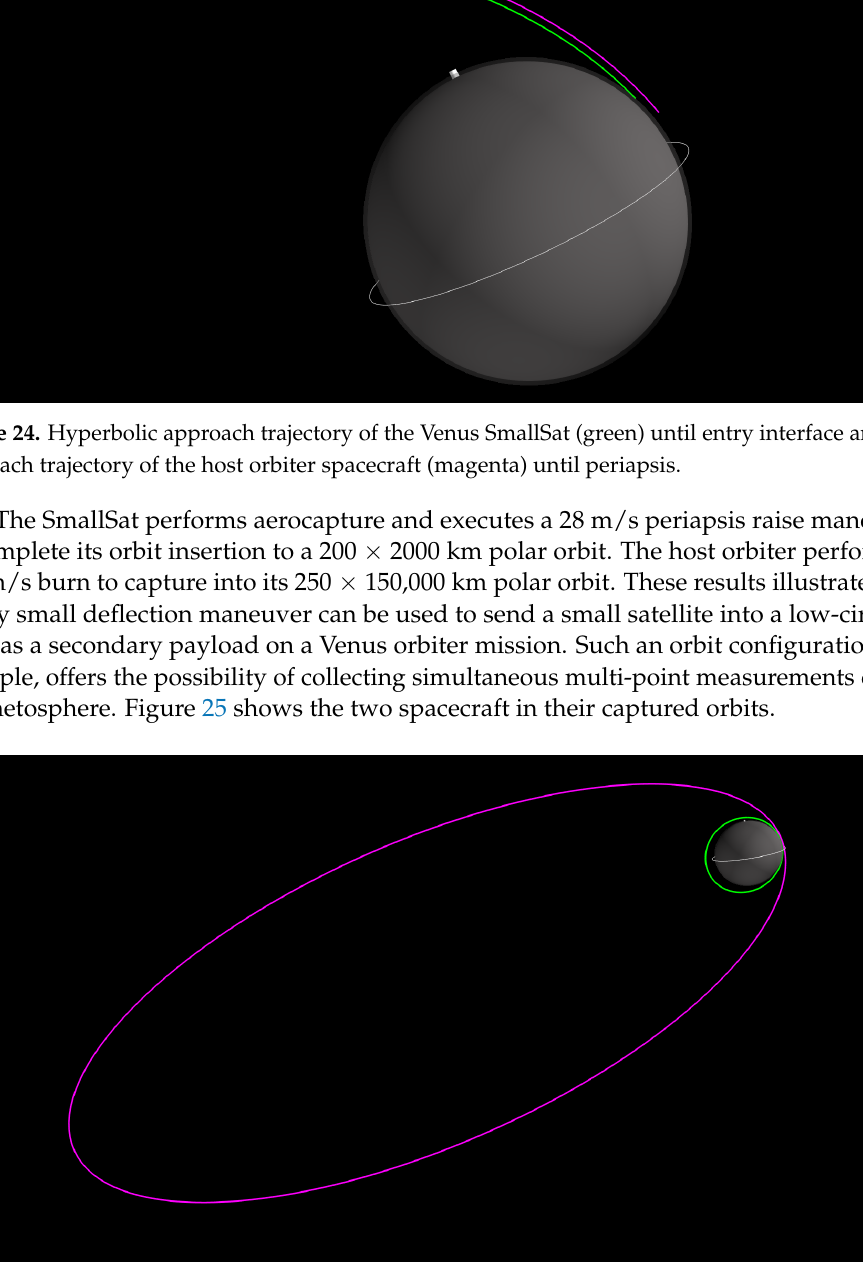
Figure 25. Venus small satellite in 200 × 2000 km polar orbit post aerocapture (green), and the host orbiter in a 400 × 150,000 km polar orbit after propulsive orbit insertion